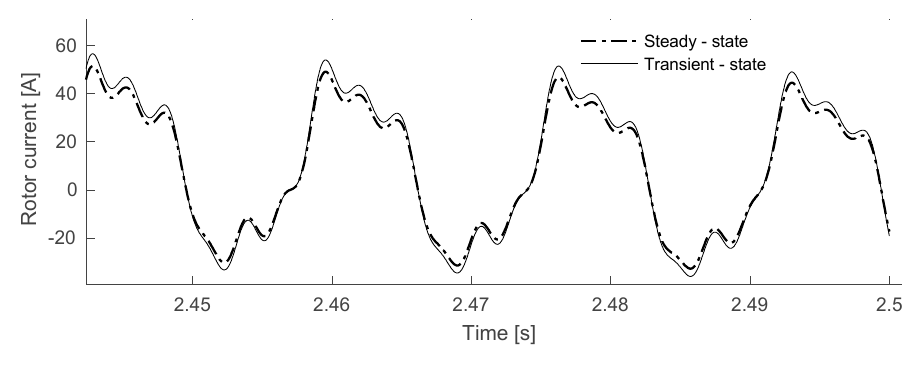
Figure 14. Rotor Figure 14. Rotor current. Table 7. Summary of harmonic currents for test case 2.